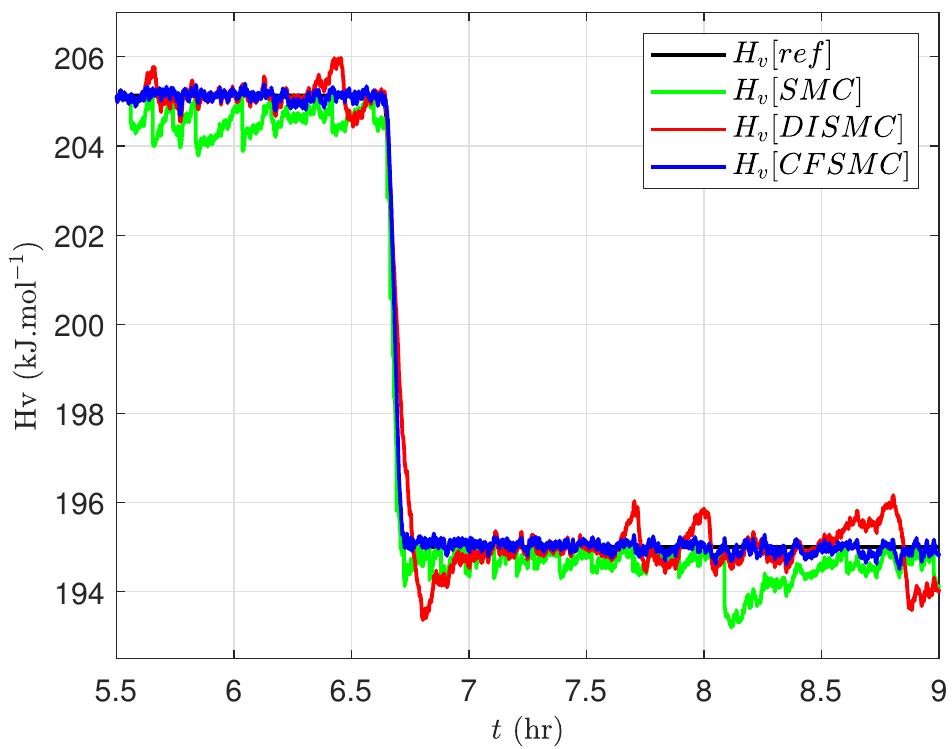
Figure 2. Syngas Heating value in the closed-loop operation with